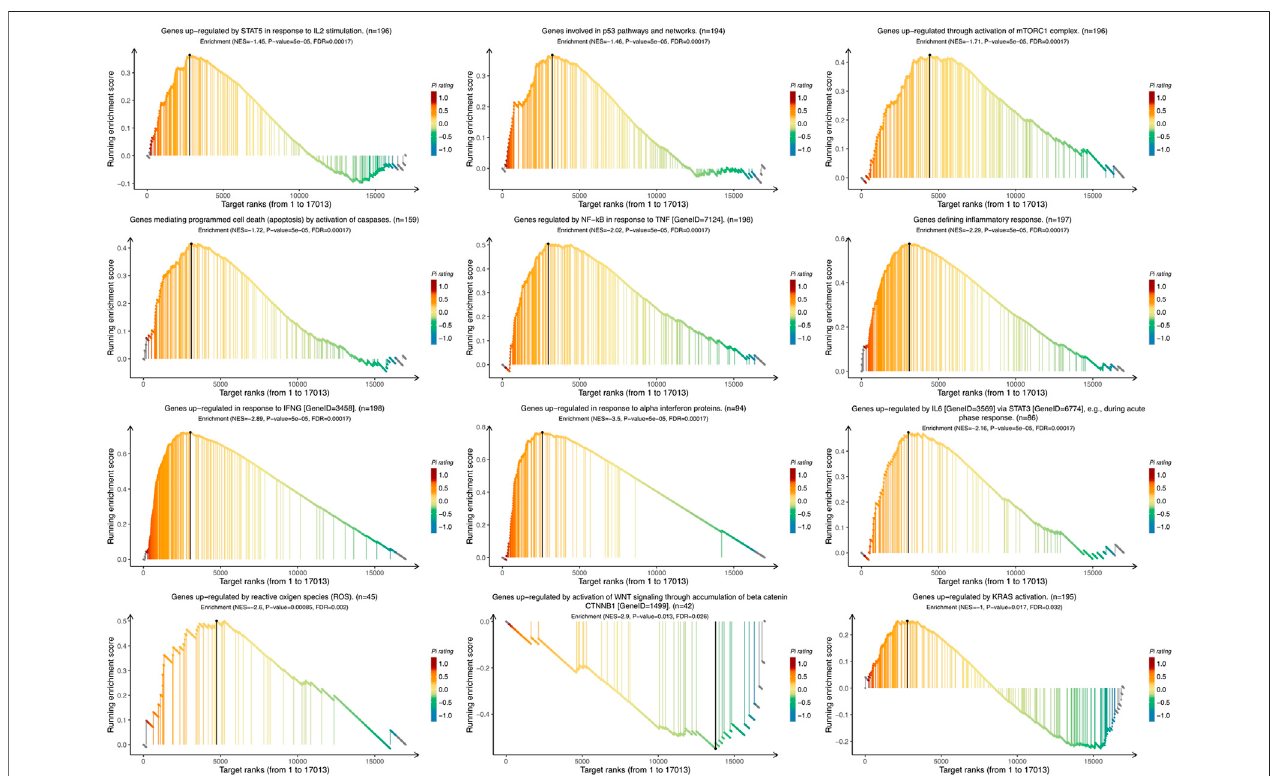
FIGURE 5 | The Gene Set Enrichment Analysis (GSEA) of the relationship between the expression level of VTCN1 in the TCGA ovarian cancer dataset. The most involved signi fi cant hallmark pathways which were closely correlated with VTCN1 in OvCa obtained by GSEA. NES: normalized enrichment score; FDR: false discovery